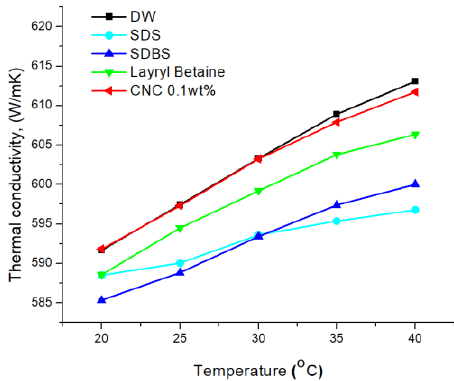
Figure 8. Thermal conductivity measurements of each surfactant.